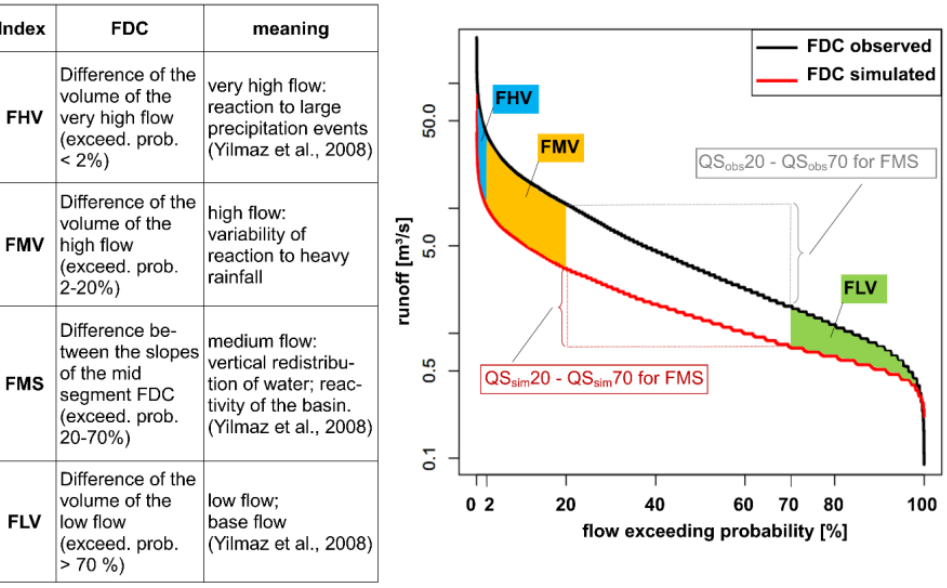
Figure 3. Meaning and position of the four signature indices derived from the FDC [23]. (Copyright permission from IWA Publishing: Ley, R.; Hellebrand, H.; Casper, M.C.; Fenicia, F. Comparing classical performance measures with signature indices derived from flow duration curves to asses model structures as tools for catchment classification. Hydrol. Res . 2016 , 47 ,